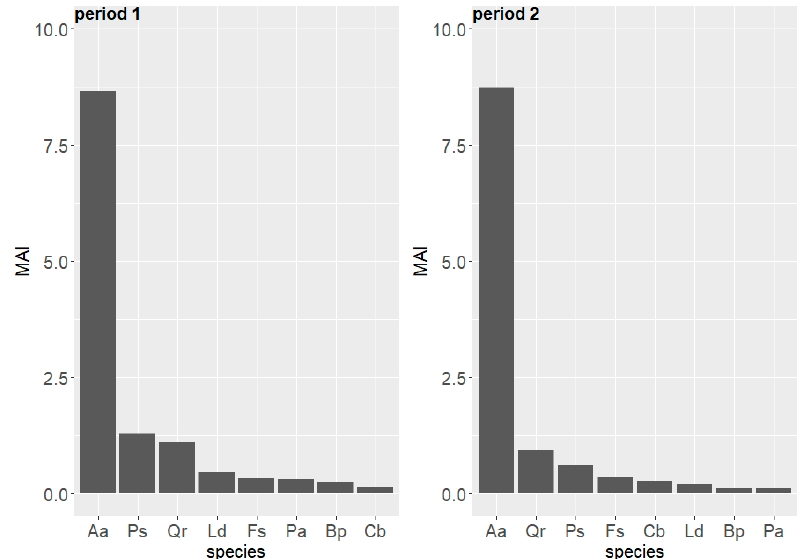
Figure 5. Species-specific mean annual volume increment (MAI, m 3 ha − 1 y − 1 ) in two periods (period 1: 1996–2006 and period 2: 2007–2017) in the uneven-aged forest located in the Unieszów Forestry Range.